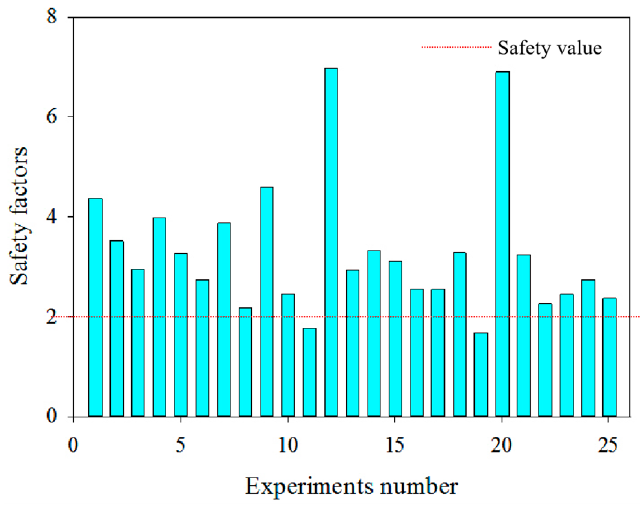
Figure 6. Safety factors of the roofs obtained by numerical simulation.